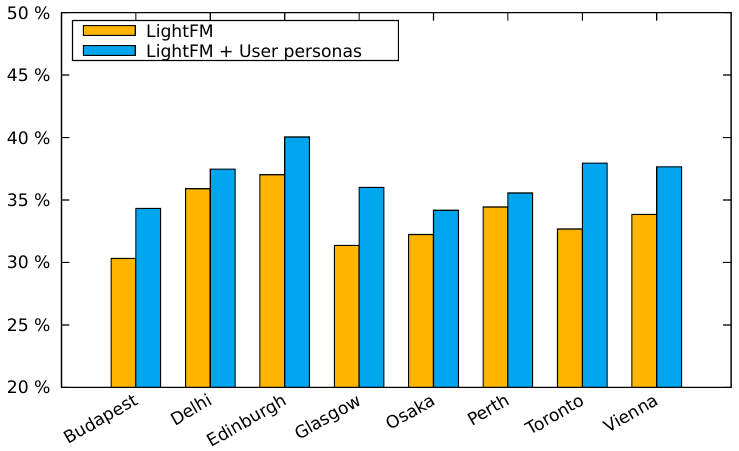
Figure 5. Mean Average Precision for a list of three items